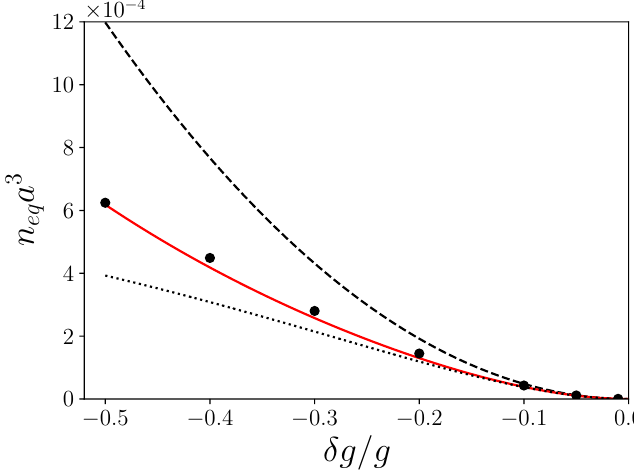
Figure 4: Equilibrium density of liquid phase as a function of δ g / g . The black dashed and dotted lines correspond to speeds of sound given by Eq. (8) and Eq. (7), respec- tively. The red solid line is the calculation within the beyond LHY theory, relying on Eq. (11), while the black dots are QMC results from Ref. [ 11 ]